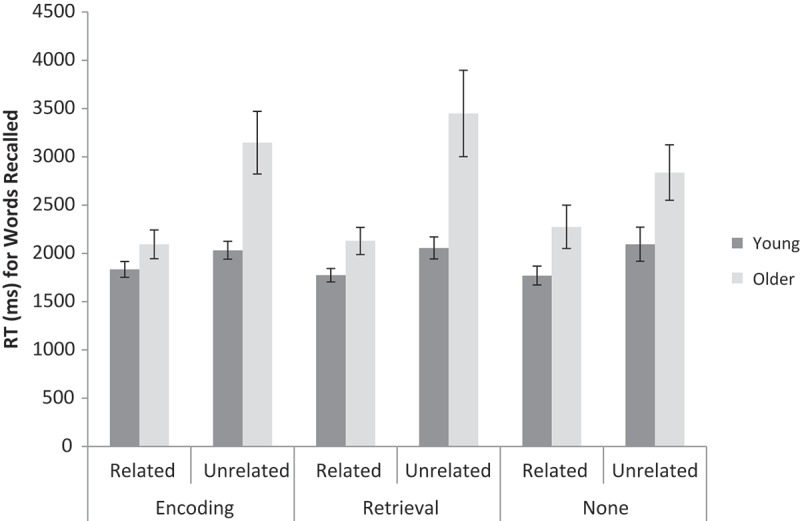
Mean RTs (based on medians for each participant) for correct responses for related and unrelated word pairs, for labels at encoding, retrieval, or no labels, and for young and older adults in Experiment 2. Error bars are ±1 SE.